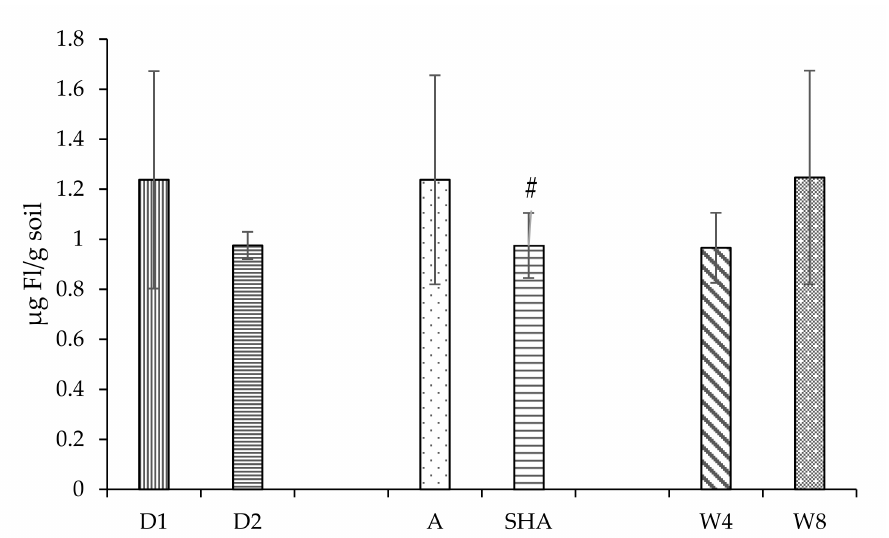
Figure 3. Summary of FDA enzyme activity results by treatments (doses), soil types, sampling weeks. The codes are as follows: D1: Dose 1. D2: Dose 2. A: Arenosol. SHA: slightly humous Arenosol. W4: Week 4. W8: Week 8. # indicates significant difference at p < 0.05 (calculated by Duncan-test) between Arenosol and slightly humous Arenosol